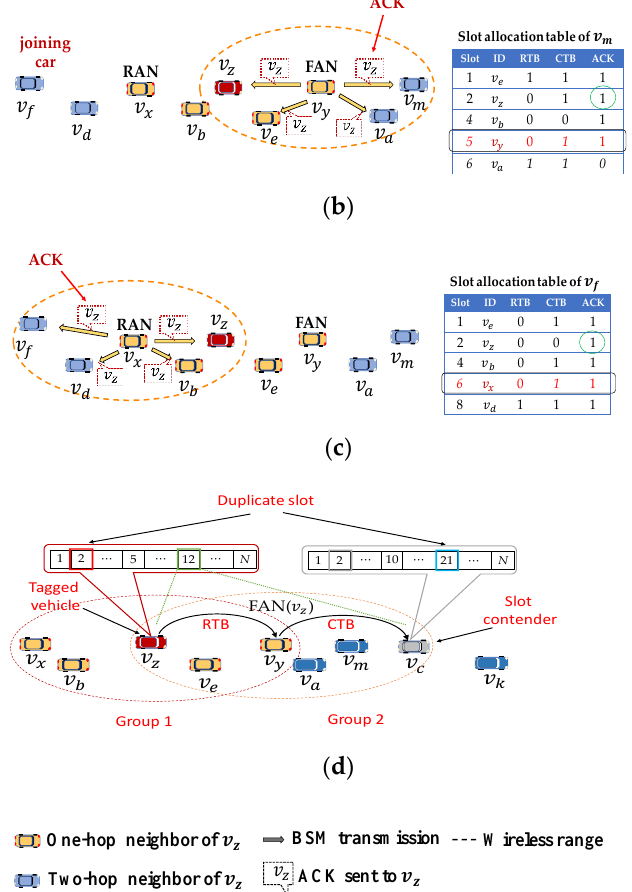
Figure 7. Implicit acknowledging in neighbor association-based medium access control (NA-MAC): ( a ) v z is sending a broadcast packet in Slot 2 ; ( b ) v y is sending ACK to v z in Slot 5 ; ( c ) v x is sending